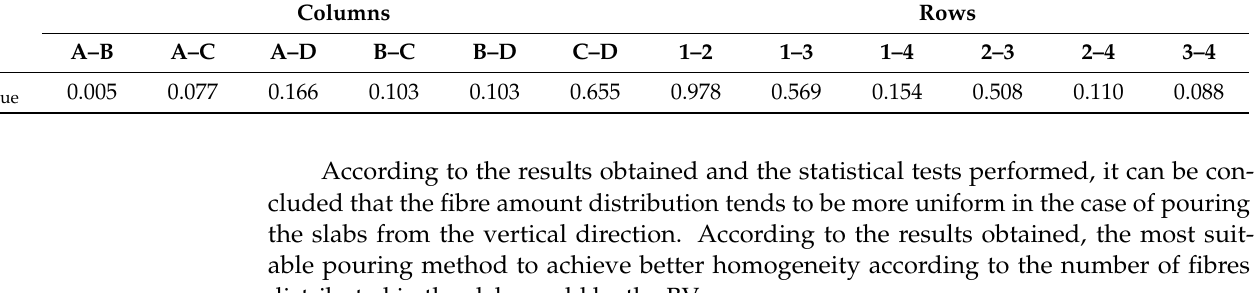
Figure 12. Distribution of fibres in each plane.